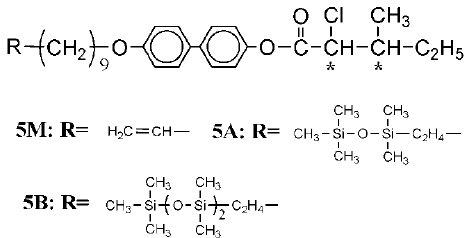
Figure 6. The phase transition temperatures of 5M, 5A, 5B, series UBPV, and series UPBV, which were measured during the cooling process. * chiral